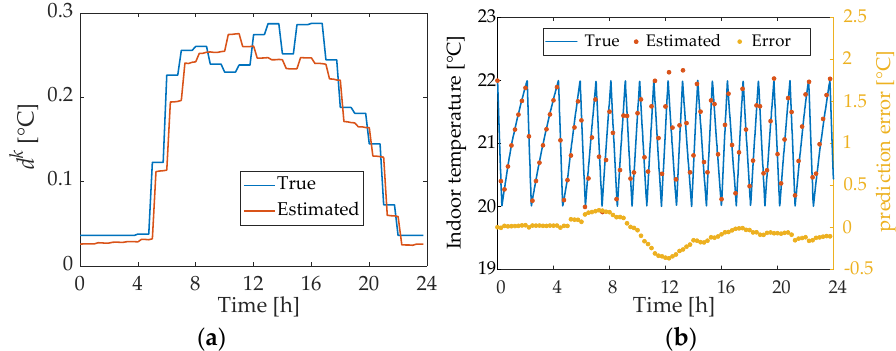
Figure 5. Estimated and true values of model parameter and indoor temperature. ( a ) Comparison of d k . ( b ) Comparison of the indoor temperature .